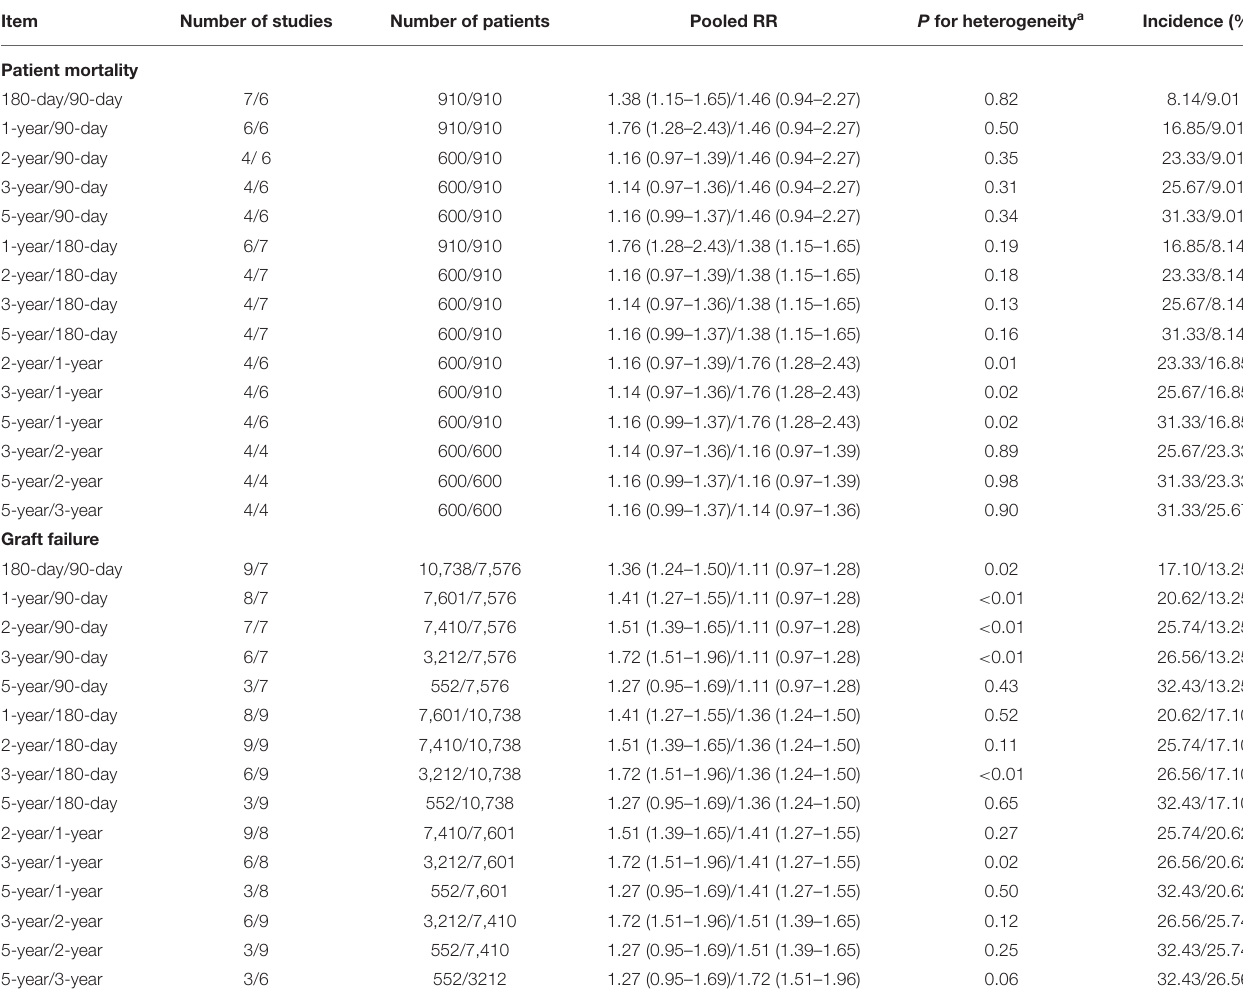
RR, relative risk. a : P represented the heterogeneity between subgroups. b : Incidence represented the rate of patient death and graft failure for included studies.